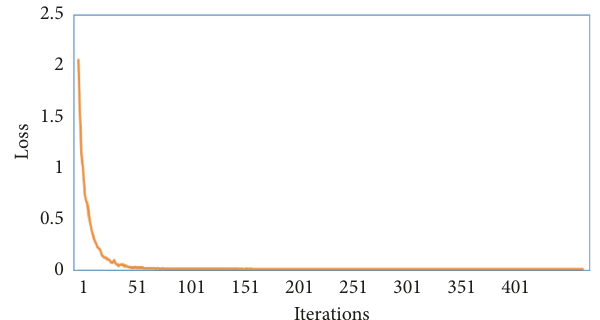
Figure 10: The loss of training process for the transfer task A ⟶